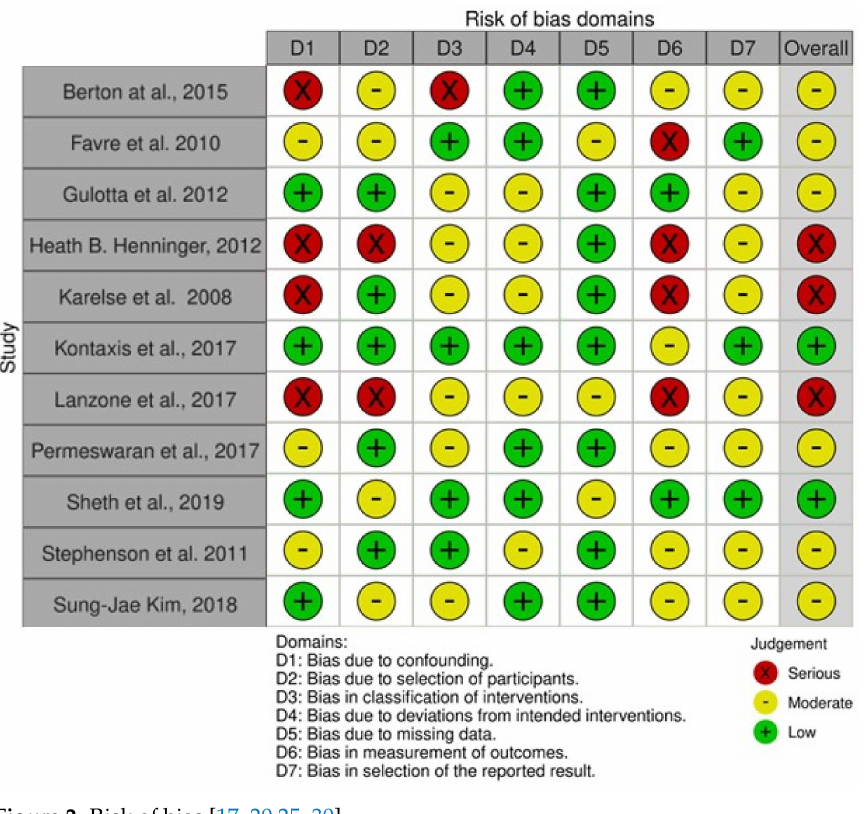
Figure 2. Risk of bias